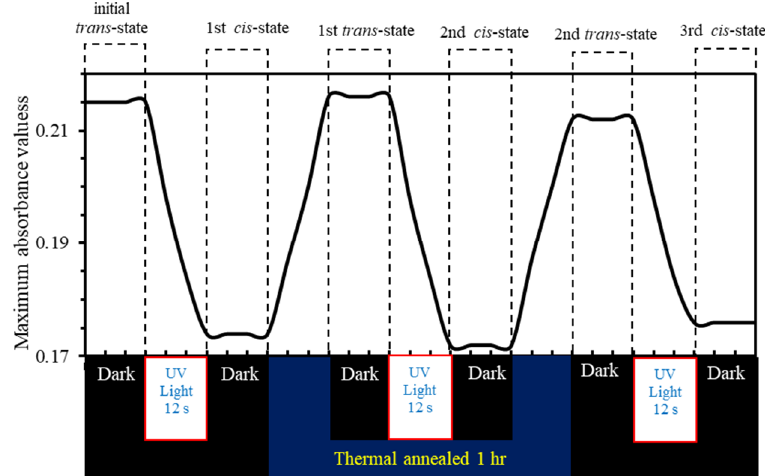
Figure 9. Absorbance spectra of PMMA-BDK-MR polymer composite thin film: Natural trans -case, cis -state after 12 s of UV-366 nm illumination and trans -state after annealing at 90 °C for 1 h.